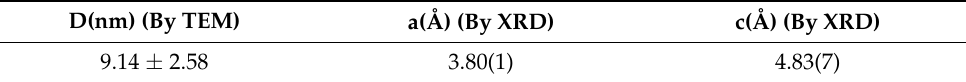
Table 1. Averaged dimensions and lattice parameters for tin oxide (SnO) estimated from TEM and XRD